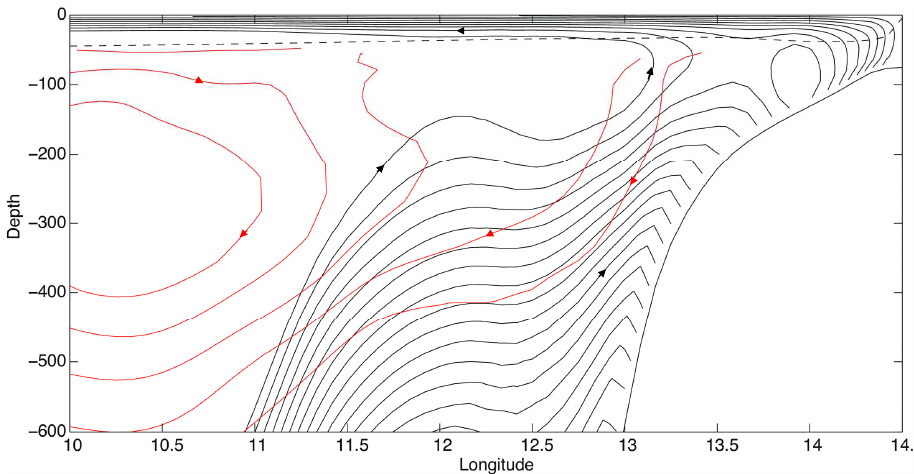
Fig. 6. Alongshore component of vector streamfunction (m 2 s − 1 ) constructed from zonal velocities. In black: mean streamfunction con- structed from the mean zonal velocity ( u ); in red: bolus streamfunction associated with the zonal bolus velocity ( u ∗ ), please see Colas et al. (2013) for details.. The dashed line represents the mean depth of mixed layer.